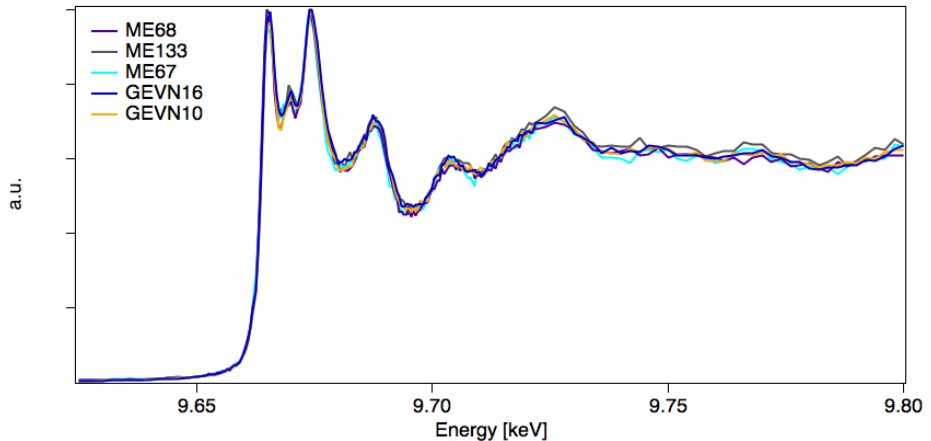
Figure 4. Zn XANES spectra acquired on a 3 µm × 4.2 µm spot on the gloss layer of samples ME68, ME133, ME67, GEVN10 and GEVN16 in cross section geometry.